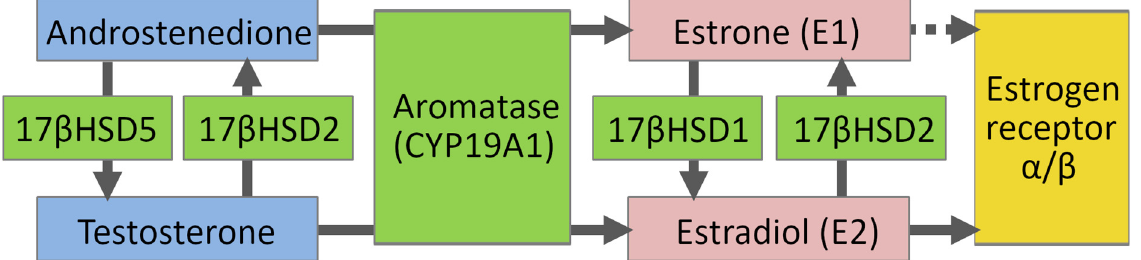
Figure 2. Steroid synthesis pathway.